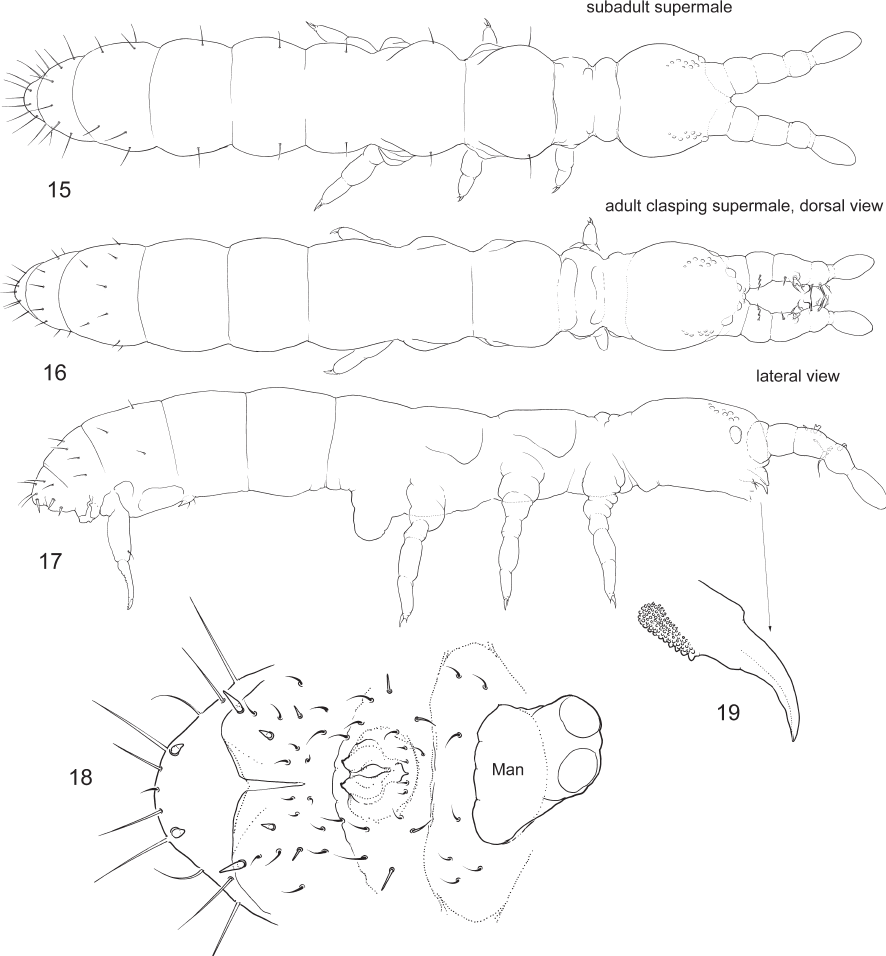
Figures 15–19. Bagnallella davidi , the “clasping supermale” 15 subadult individual, dorsal view 16, 17 adult, dorsal 16 and lateral 17 views 18 posterior part of abdomen in adult male, ventral view 19 mandible. Man = Diagnosis. 3+3 postlabial chaetae. Maxillary palp simple. Dens with four anterior and four posterior chaetae. Mucro tridentate, teeth arranged in a line. Anterior side of manubrium with 1+1 chaetae. 43/22235 s and 10/100 ms on body (Figs 9–11). No ventral chaetae on Th.III. Typical form of species with long macrochaetae (Fig. 10). Description. Maxillary outer lobe with four sublobal hairs, maxillary palp simple. Labral formula as 4/5,5,4. Labium with five usual papillae (– Е ) and labial formula A1B4C0D4E6, guard chaeta e7 absent, three proximal and four basomedian chae-